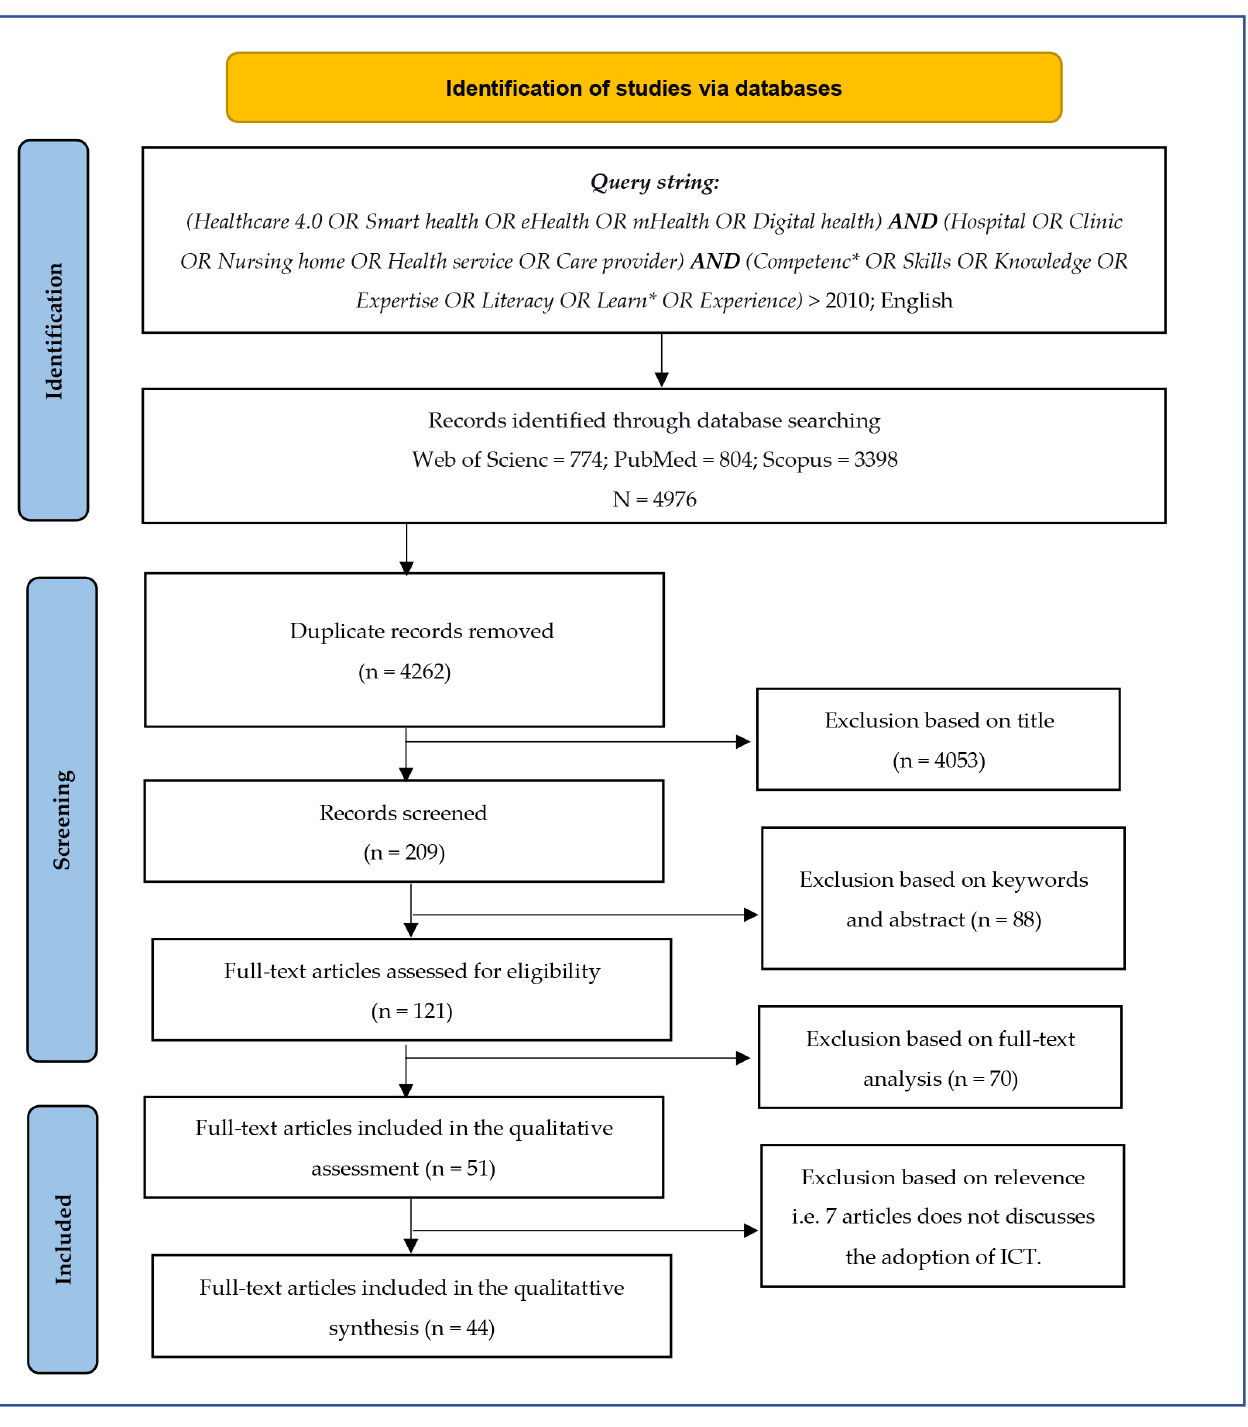
Figure 1. Flowchart of identification of studies via database search.